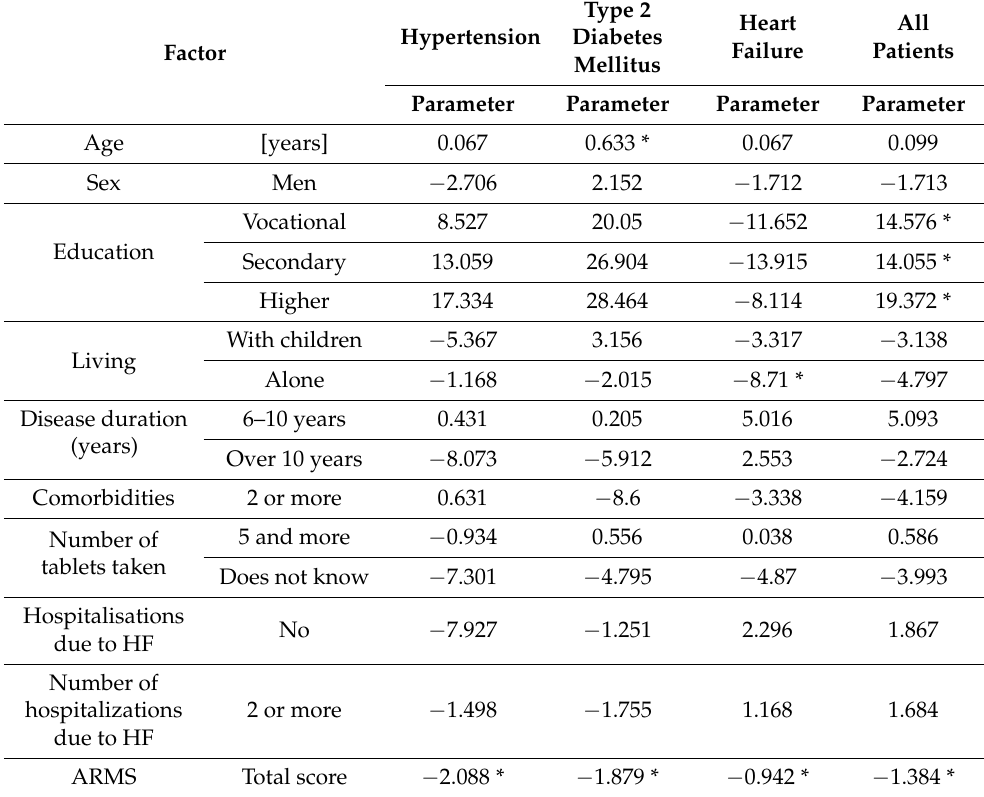
Table 5. Results of multiple factor regression